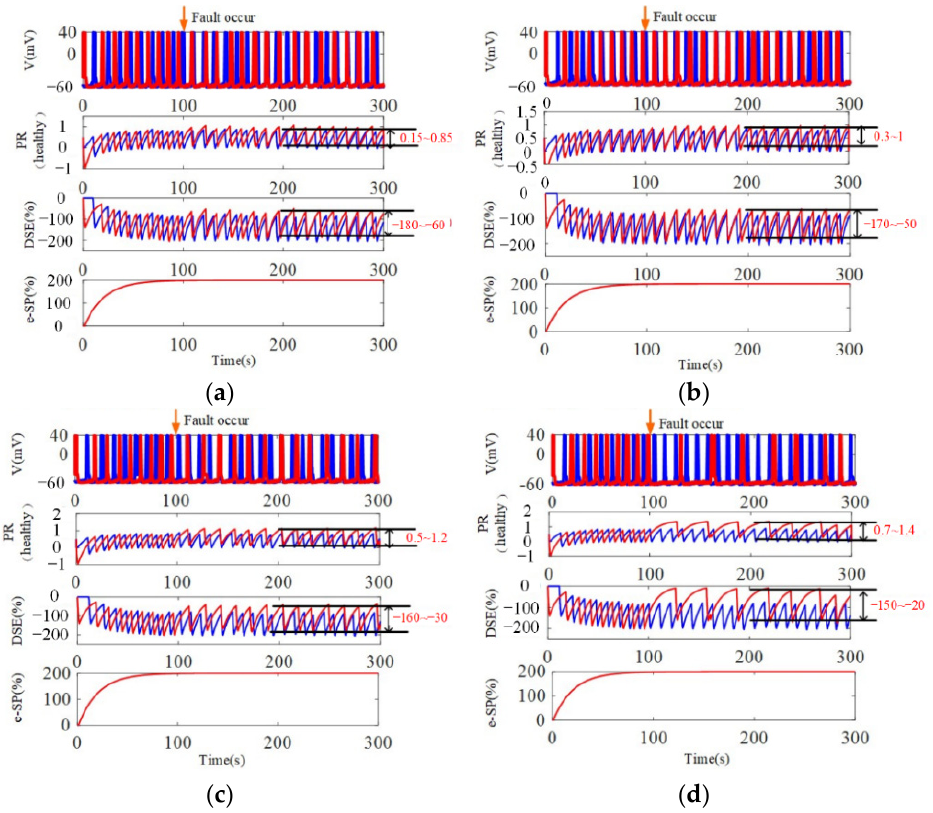
Figure 6. The dynamic behaviors of synapses connected with the CPG neurons when the neuron LP encountered synaptic failure at 100 s. The red parts indicate the neuron LP, and the blue parts indicate the neuron PD with no fault. The fault densities include ( a ) 20%, ( b ) 30%, ( c ) 40%, and ( d ) 50%. Each figure includes the member potentials of the astrocyte-mediated BiSRP-CPG, the PR of healthy synapses connected to neuron LP and neuron PD, DSE signal, and eSP signal.